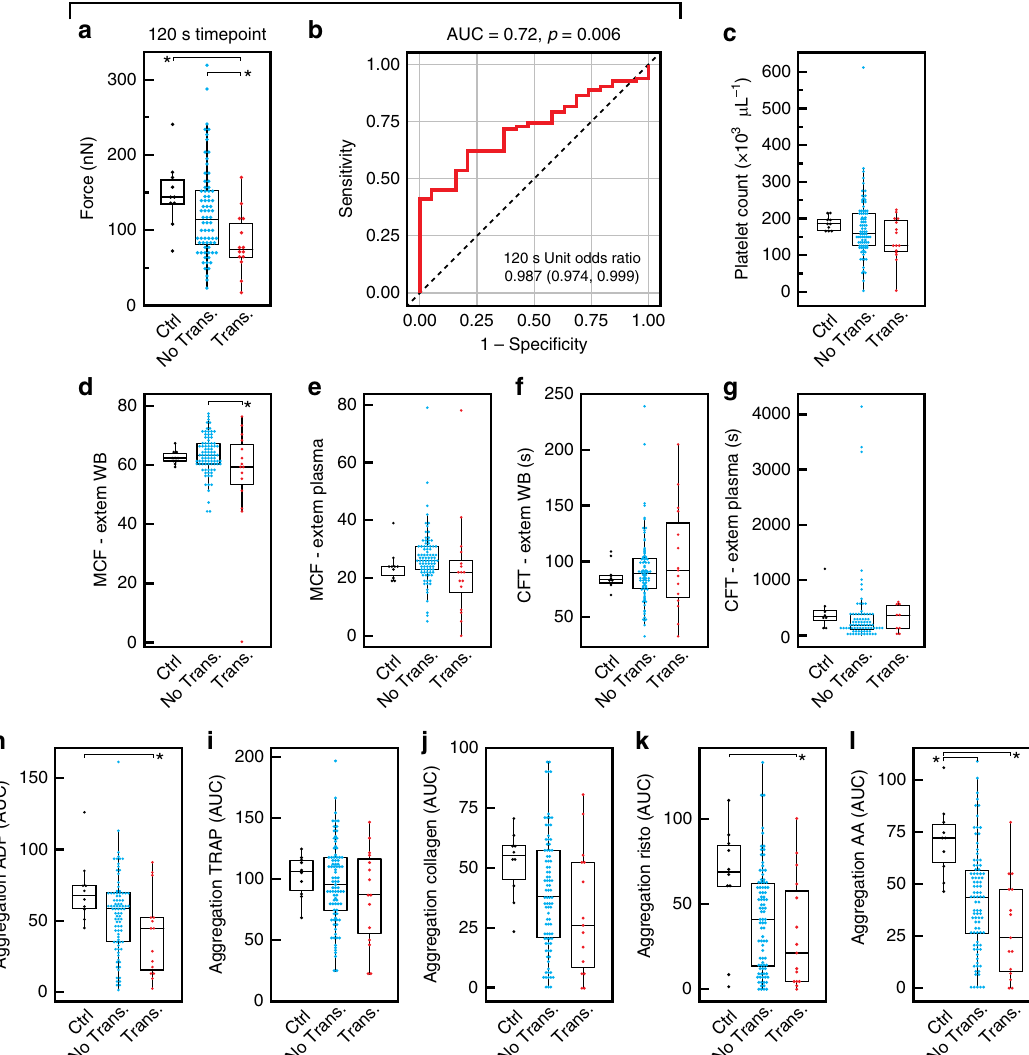
Fig. 4 Platelet forces are indicative of bleeding risk in trauma patients. In a prospective cross-sectional observational study of Emergency Department trauma patients at a regional trauma center ( N = 110 patients), blood was sampled upon arrival to the Emergency Department. a Platelet forces differed among healthy controls and trauma patients when strati fi ed by need for blood product transfusion within the fi rst 24 h of hospital care. Mean force was signi fi cantly decreased for those requiring transfusion (red diamonds) compared to both healthy controls (black diamonds) and vs. trauma subjects who did not require transfusion (magenta diamonds). b Receiver operating characteristics revealed that platelet forces signi fi cantly predicted the need for transfusion. c Platelet count was in the normal range for all three groups and was not different between groups. d , e Rotational thromboelastometry (ROTEM) showed that maximum clot fi rmness (MCF) was decreased in whole blood for transfused vs. not transfused trauma groups, but was not different between groups when measured in plasma. f , g There were no differences in ROTEM clot formation time (CFT) between groups when measured in whole blood and in plasma. h – l Platelet aggregation responses measured by the area under the aggregation curve (AUC) were signi fi cantly different when aggregation was activated by adenosine diphosphate (ADP), ristocetin, and arachidonic acid. There were no differences in aggregation between groups when activated by thrombin activating peptide (TRAP), or collagen. Platelet aggregation did not distinguish between transfused and non-transfused trauma patients. Body of the box plots represent fi rst and third quartiles. Center lines denote the median. Whiskers extend from the quartiles to the last data point within 1.5× interquartile range, with outliers beyond. Data points represent results from a single subject. Asterisks denote statistically signi fi cant differences (* p < 0.05) using one-way analysis of variance (ANOVA) followed by Tukey ’ s post-hoc test (Fig. 4j). The transfused trauma group showed decreased activators (Supplementary Table 3). Aggregation AUC measure- aggregation vs. healthy controls only for ADP (Tukey p = ments were also independent of platelet count ( R 2 values for ADP: 0.242, TRAP: 0.125, collagen: 0.113, ristocetin: 0.167, AA: 0.018) and ristocetin activation (Tukey p = 0.036). For AA 0.269). Taken together, platelet forces, ROTEM, and aggrego- activation, aggregation was decreased in both the non-transfused metry data support an effect of trauma on platelet function. trauma group (Tukey p = 0.002) and the transfused trauma group However, only platelet forces were able to distinguish transfused (Tukey p < 0.001) when compared to healthy controls. There were trauma patients conclusively from both healthy controls and non- no signi fi cant differences in aggregation for trauma patients transfused trauma patients. between the transfused and non-transfused groups for any NATURE COMMUNICATIONS| (2019) 10:1204